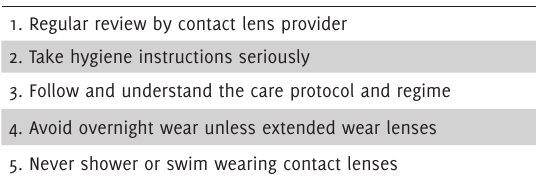
Table 2. Avoiding contact lens-related